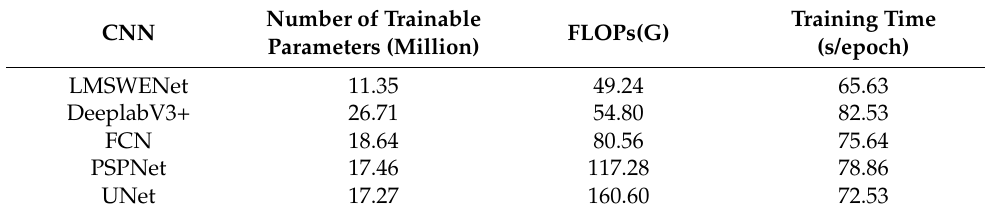
Table 6. The efficiency comparison of the